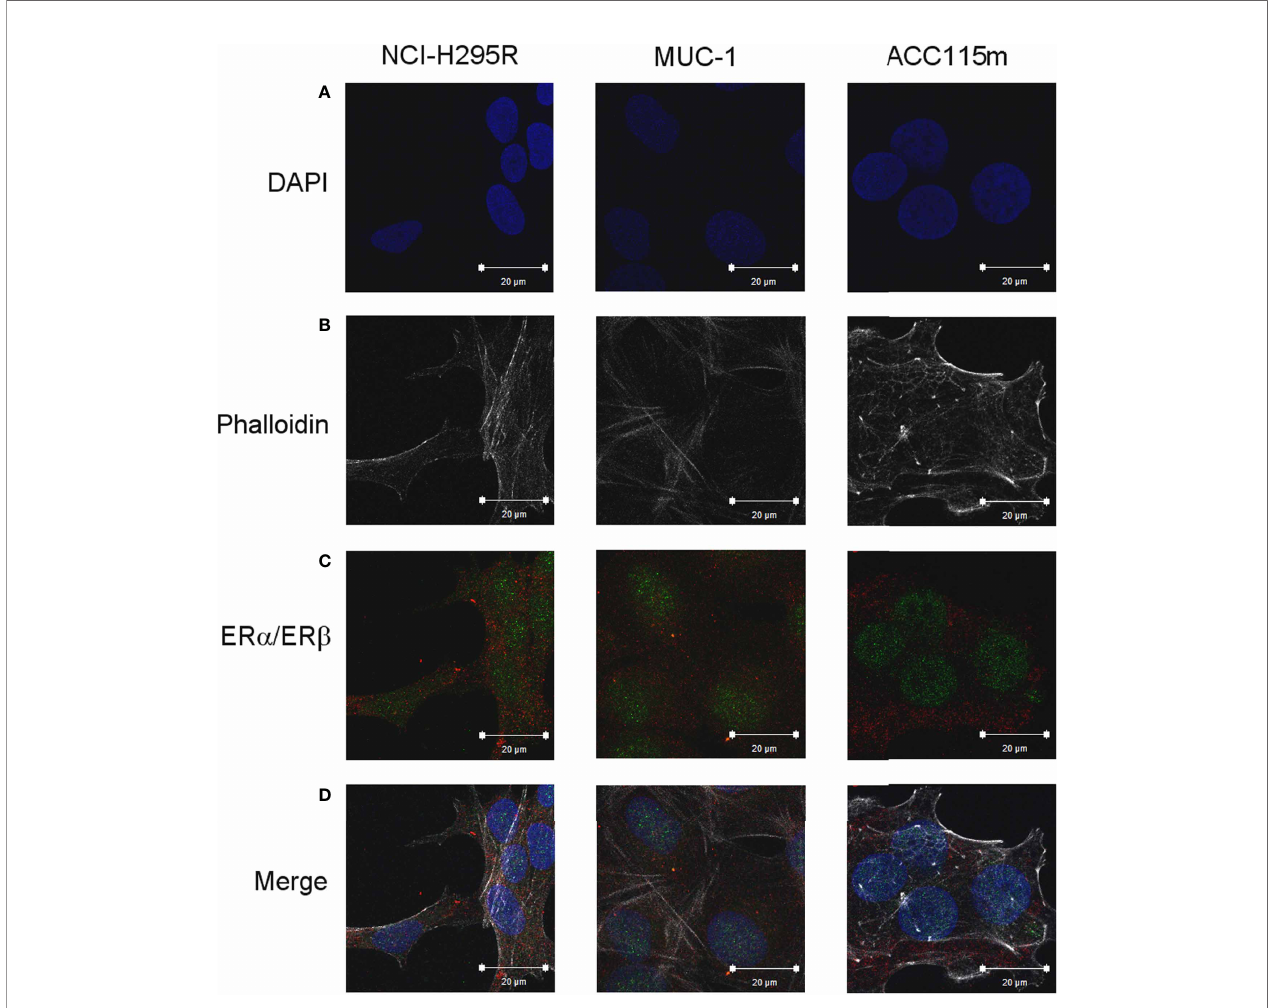
FIGURE 1 | ER expression in NCI-H295R, MUC-1 cell lines and ACC115m primary culture. Cells were seeded on poly-L-lysine pre-treated coverslips following by incubation with DAPI for nuclear staining. Panel (A) DAPI; panel (B) phalloidin; panel (C) ER (red signal: ER- a ; green signal: ER- b ); panel (D) merge. The scale bar of 20 µm is automatically inserted by the software ZEN